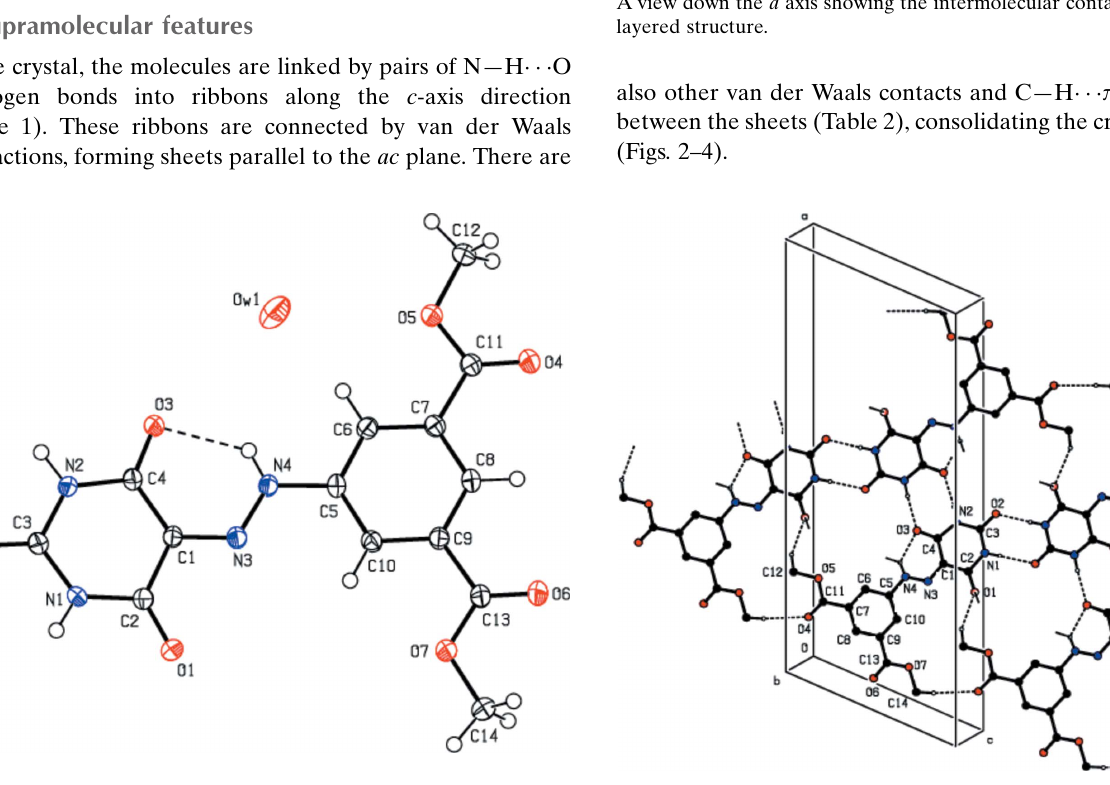
Figure 1 The molecular structure of the title compound, showing the atom labelling and displacement ellipsoids drawn at the 50% probability level.